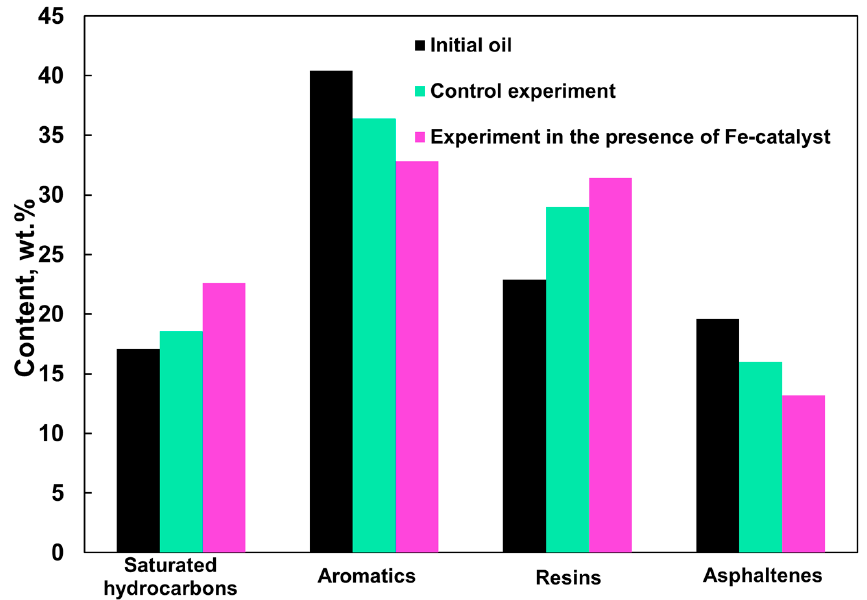
Figure 1. SARA analysis of the initial heavy oil and oil after the batch reactor processing at higher temperature (250 °C) and pressure (90 atm) in the absence (control experiment) and in the presence of iron tallates.